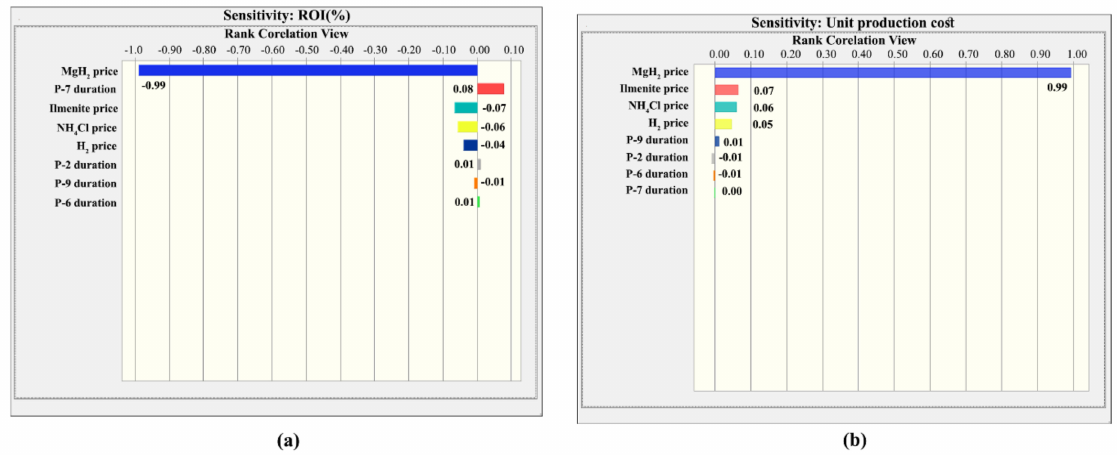
Figure 11. Contribution of uncertain parameters to the variance of ( a ) ROI and ( b ) unit production